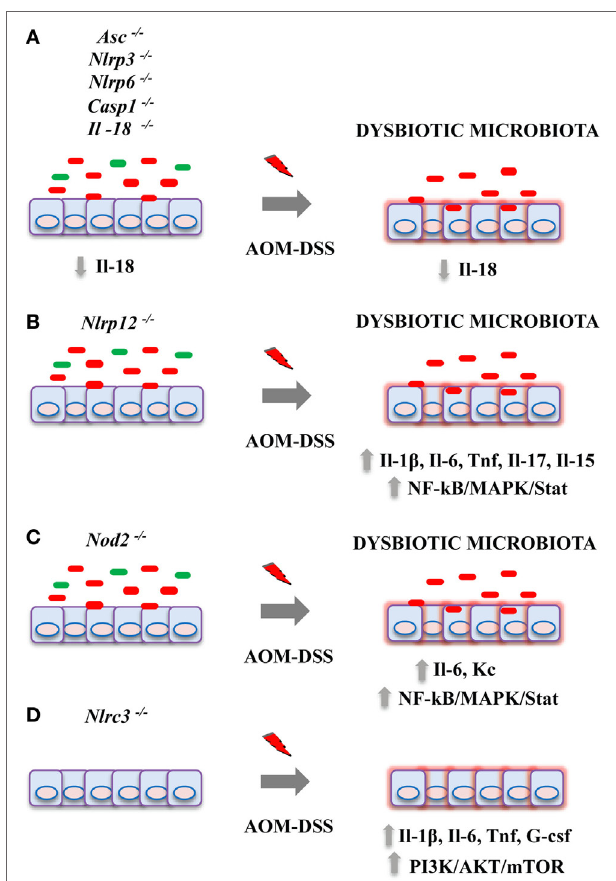
FigURe 1 | Effects of nucleotide-binding domain leucine-rich repeat containing (NLR) proteins deficiency on colitis-associated cancer (CAC) development in pre-clinical models. Genetic alterations in NLR proteins result in an increased tumor burden in azoxymethane (AOM)-dextran sulfate sodium (DSS) mouse model of CAC by acting on multiple mechanisms. (A) Deficiency for Asc, Nlrp3, Nlrp6, Casp1, or Il-18 genes led to a dysbiotic microbiota, reduced colonic Il-18 levels, and an impairment of intestinal tissue repair upon injury; (B) Nlrp12; and (C) Nod2 deficiency have been associated with an overgrowth of inflammatory bacteria, enhanced cytokine production, and activation of pro-tumorigenic pathways including NF-kB, MAPK, and Stat3. (D) Knockout for Nlrc3 led to increased colonic inflammation and mTOR signaling